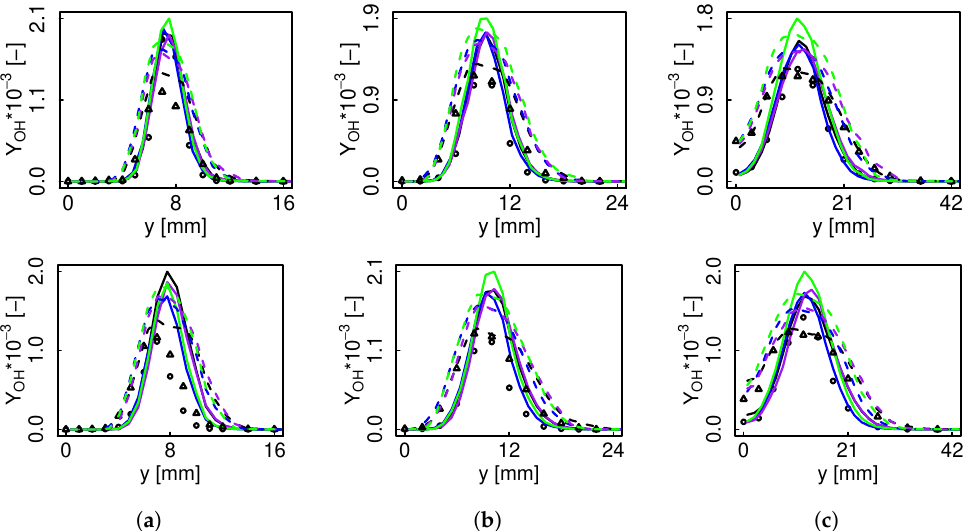
Figure 17. OH mean and RMS radial profiles for flame D ( top ) and E ( bottom ). Black color represents non-premixed FTACLES, blue color premixed FTACLES, purple color non-premixed unfiltered manifold, green color premixed unfiltered manifold. Solid line depicts mean, dashed line RMS, circles experimental mean, and triangles experimental RMS. ( a ) x / d = 7.5; ( b ) x / d = 15; ( c ) x / d =